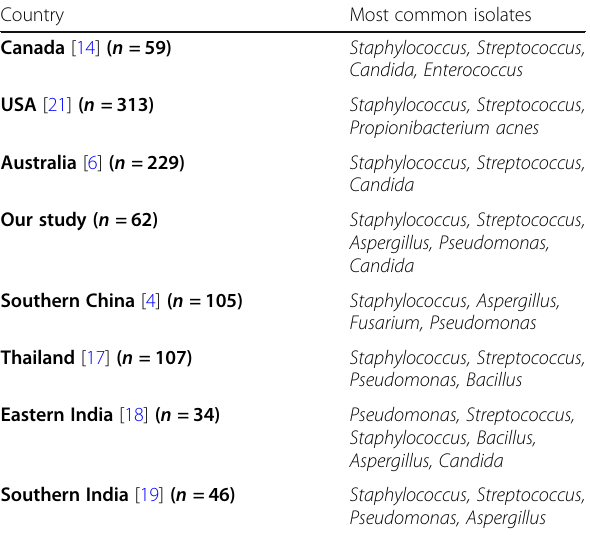
Table 10 Most common organisms compared to other countries. The most prevalent organisms